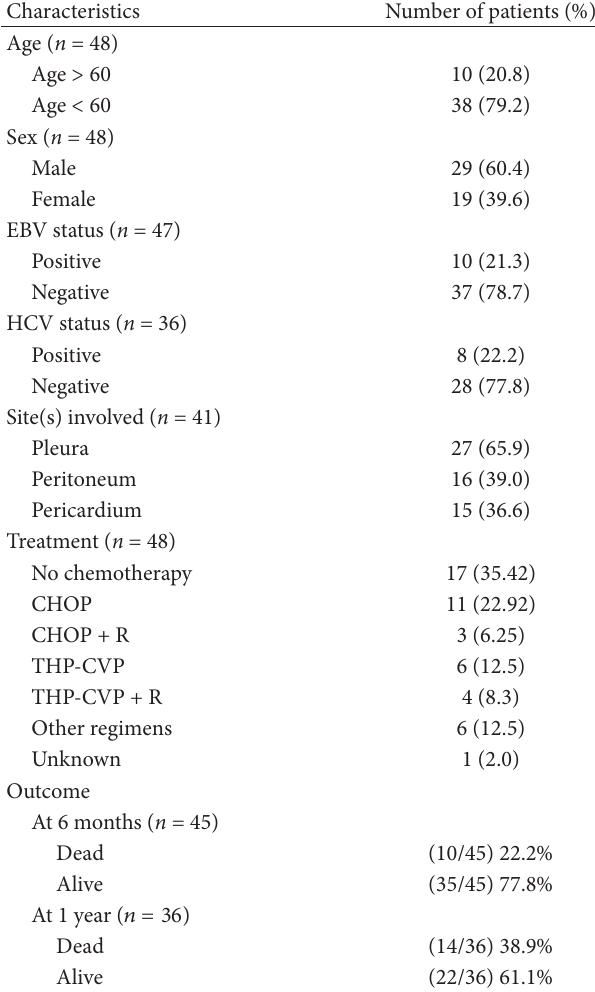
T 1: Summary of clinical characteristics of 48 patients with HHV8-negative effusion lymphomas of B-cell